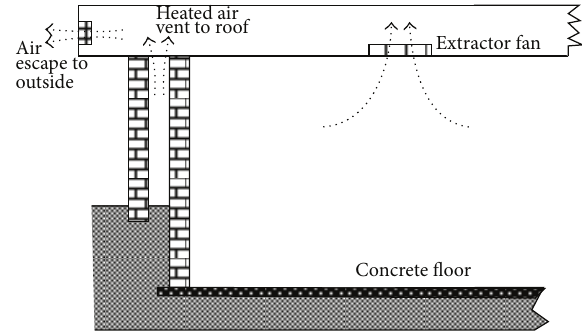
Figure 1: Cross-section through